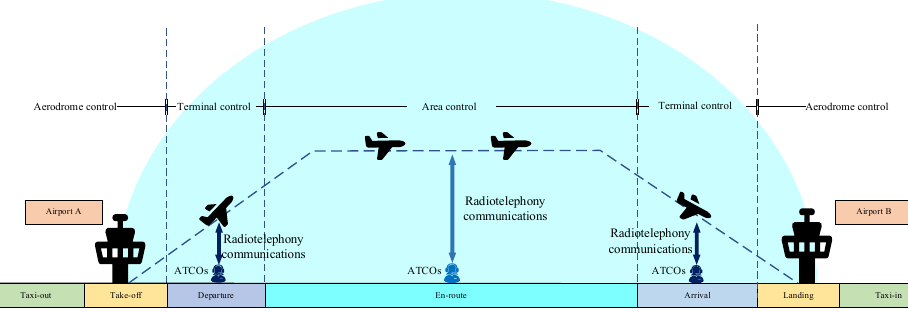
Figure 1. Diagram of control area.